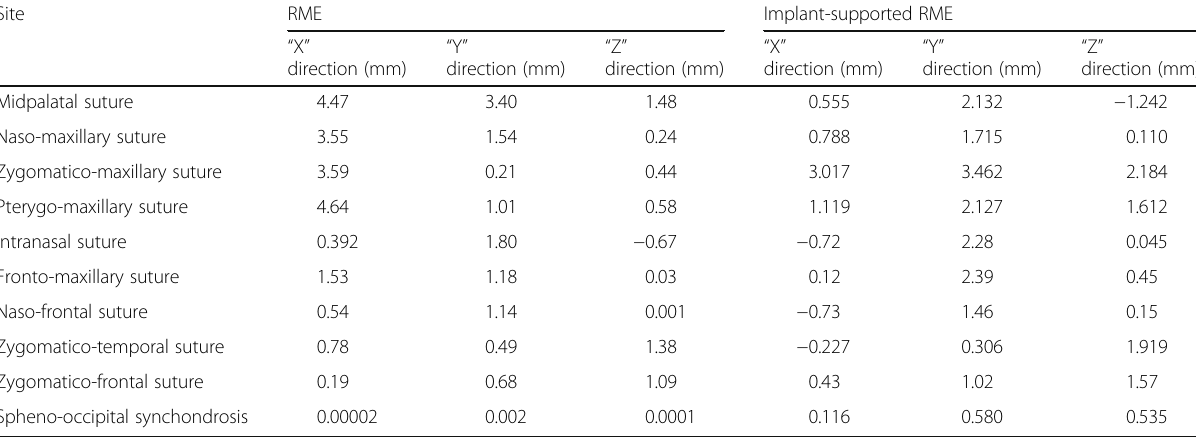
Table 3 Comparison of displacement between RME and I-RME Site